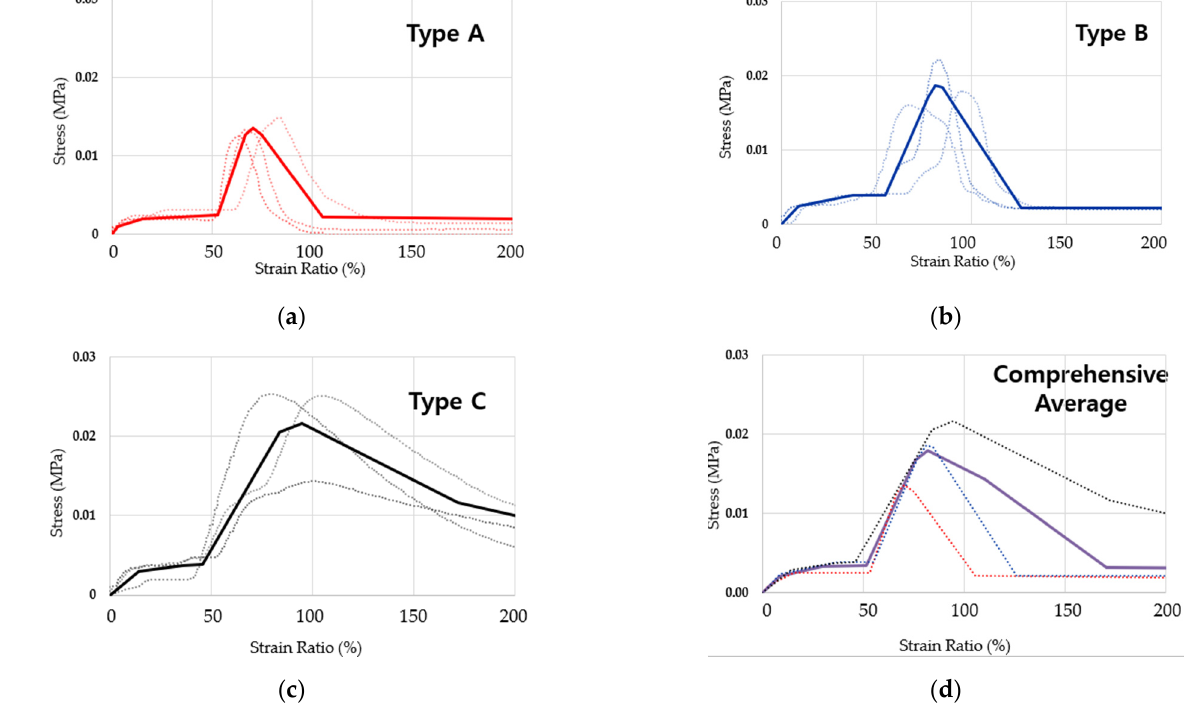
Figure 6. Yield stress derivation based on the 3 types of SPRG average results; ( a ) SPRG Type A averaged result, ( b ) SPRG Type B averaged result, ( c ) SPRG Type C averaged result, ( d ) comprehensive averaged result (Type A, B and C).